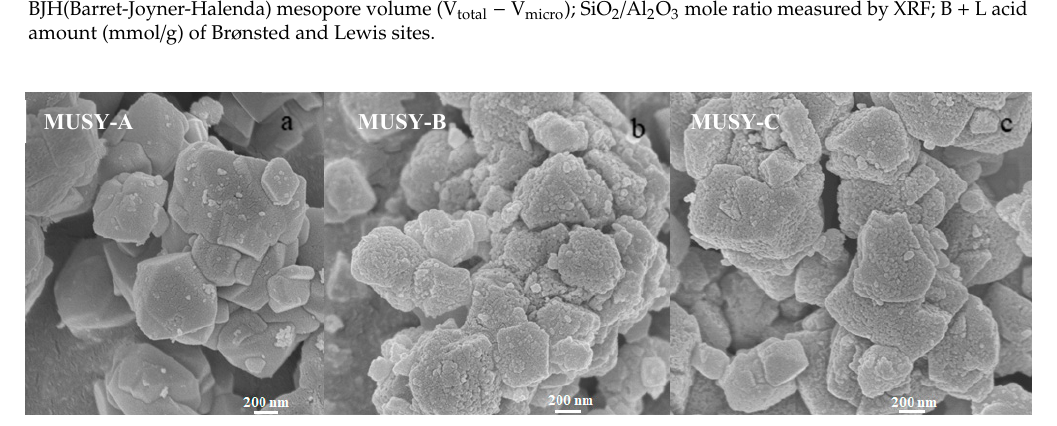
Figure 2. SEM images of the zeolites. MUSY-A ( a ), MUSY-B ( b ), and MUSY-C ( c ).